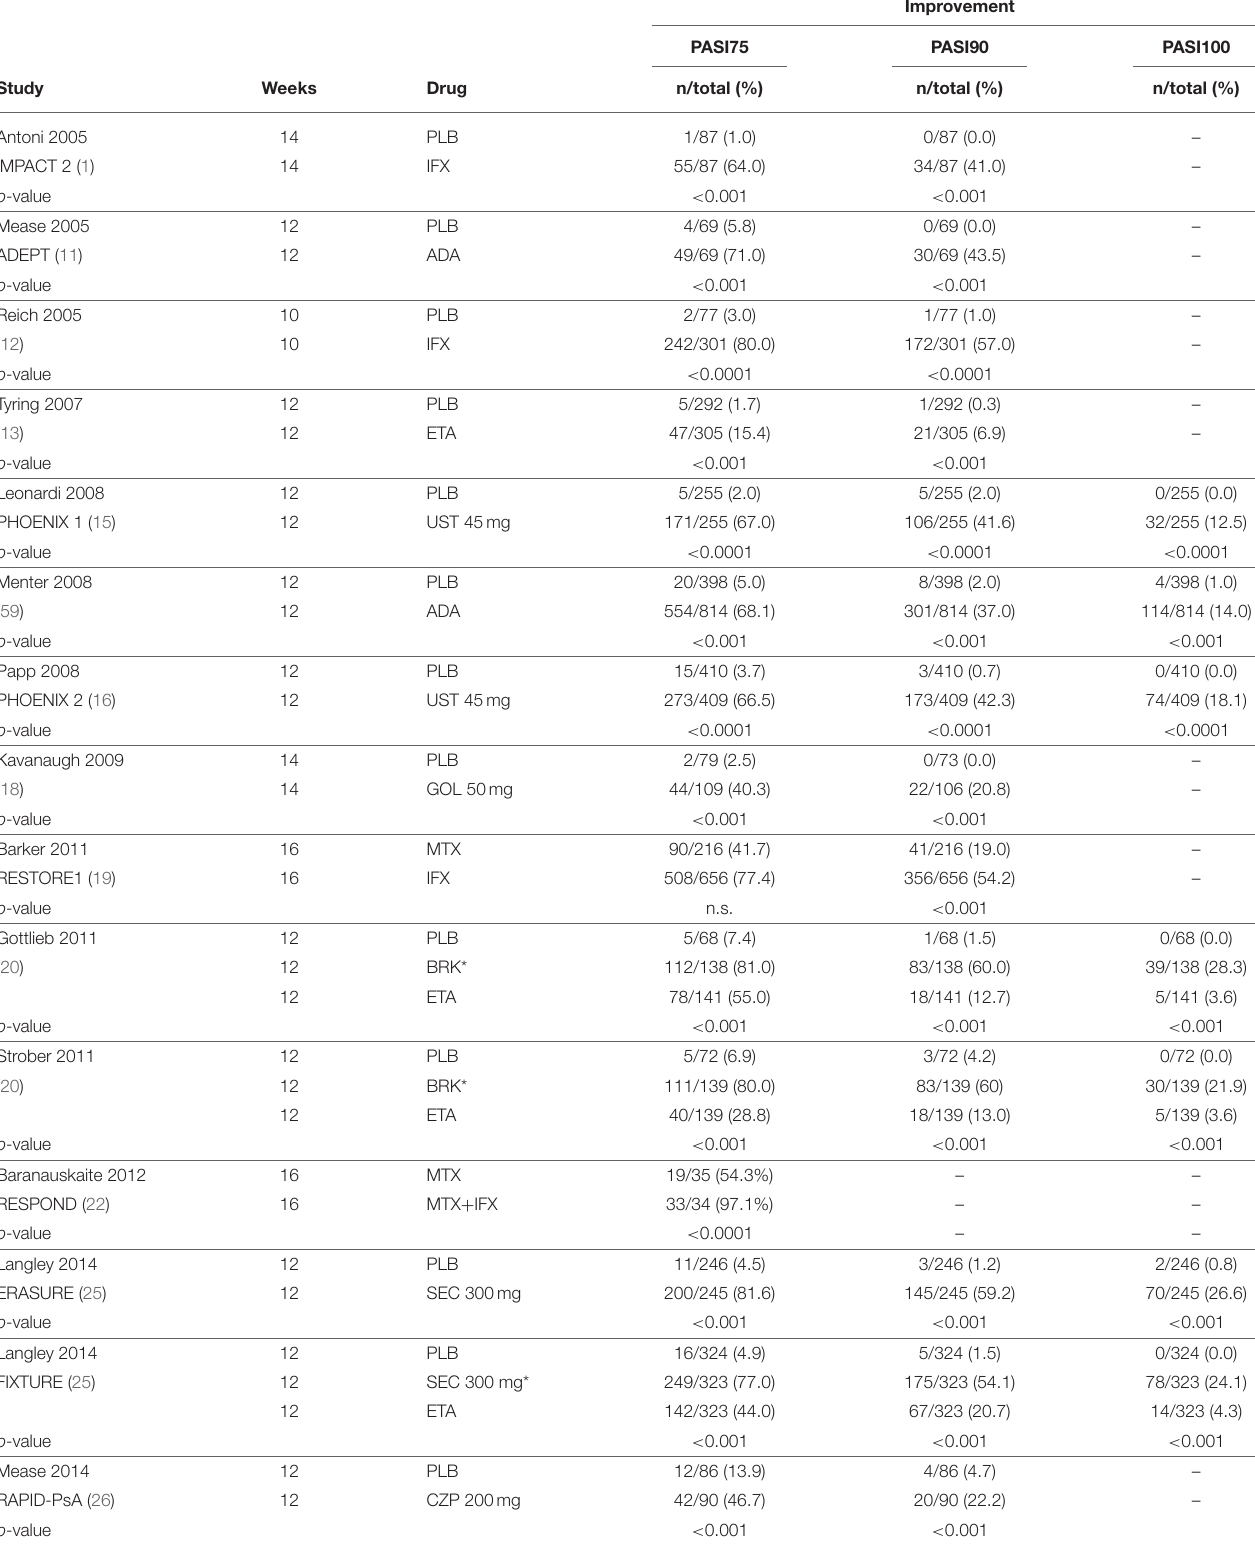
TABLE 7 | PASI Improvements in patients with psoriasis